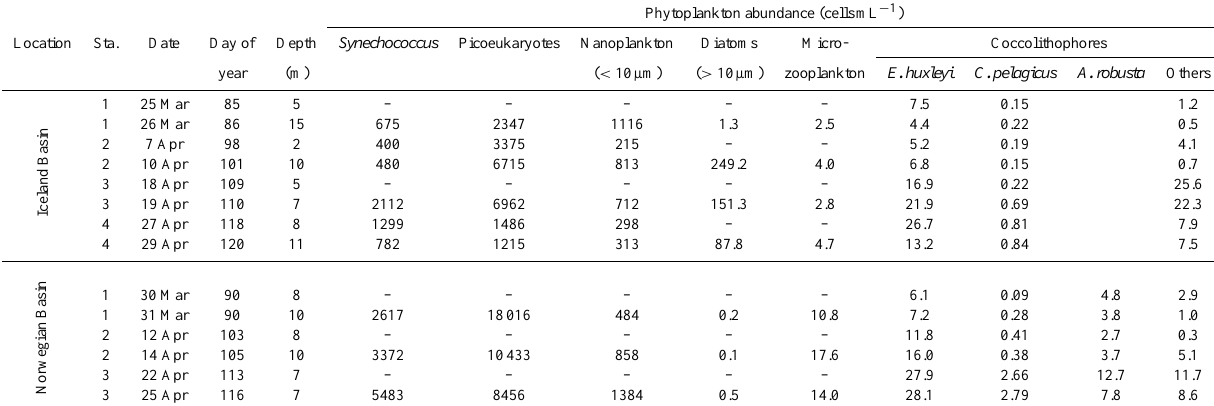
Table 3. Phytoplankton abundance at the Iceland Basin and Norwegian Basin stations, measured by flow cytometry ( Synechococcus , pi- coeukaryotes, and nanoplankton), inverted microscopy (diatoms and microzooplankton), and polarising light microscopy (coccolithophores). Sta. stands for station.